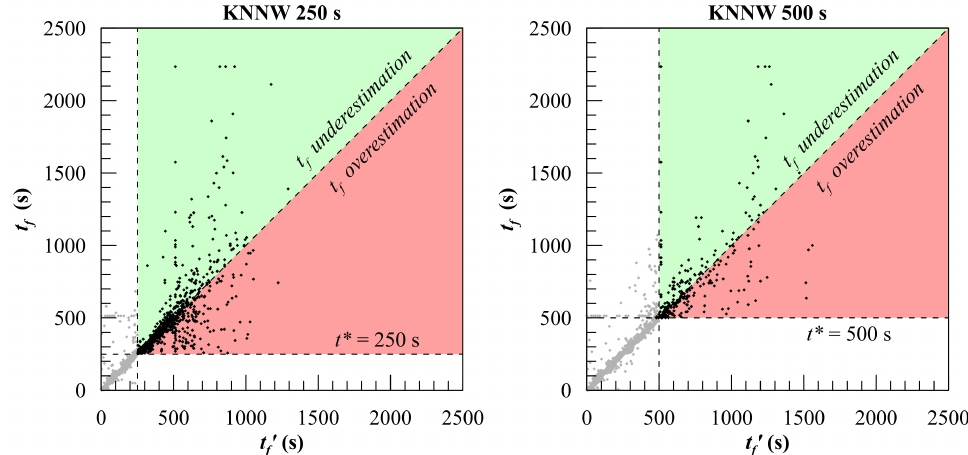
Figure 12. Predicted over observed values of the time-to-flood computed at 250 s and 500 s from damage occurrence according to KNNW method. Training: MC20; validation: